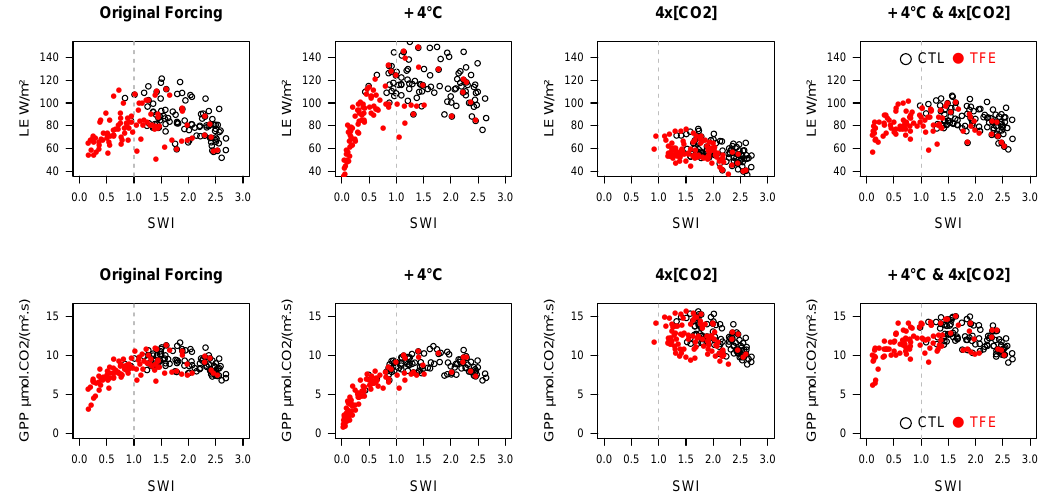
Figure 11. Simulated monthly evapotranspiration (LE) and gross primary production (GPP) vs. monthly soil wetness index (SWI) using the Simulated monthly LE and GPP vs monthly SWI using the Linear WSF, under undisturbed and disturbed linear water stress function (WSF), under undisturbed and disturbed meteorological forcings for both control (CTL) (black empty dots) and meteorological forcings for both CTL (black empty dots) and TFE (red full dots) plots at Caxiuan˜a. throughfall exclusion (TFE) (red full dots) plots at